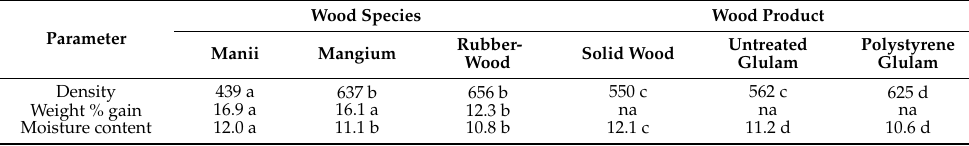
Table 2. Variance analysis summary of physical properties.